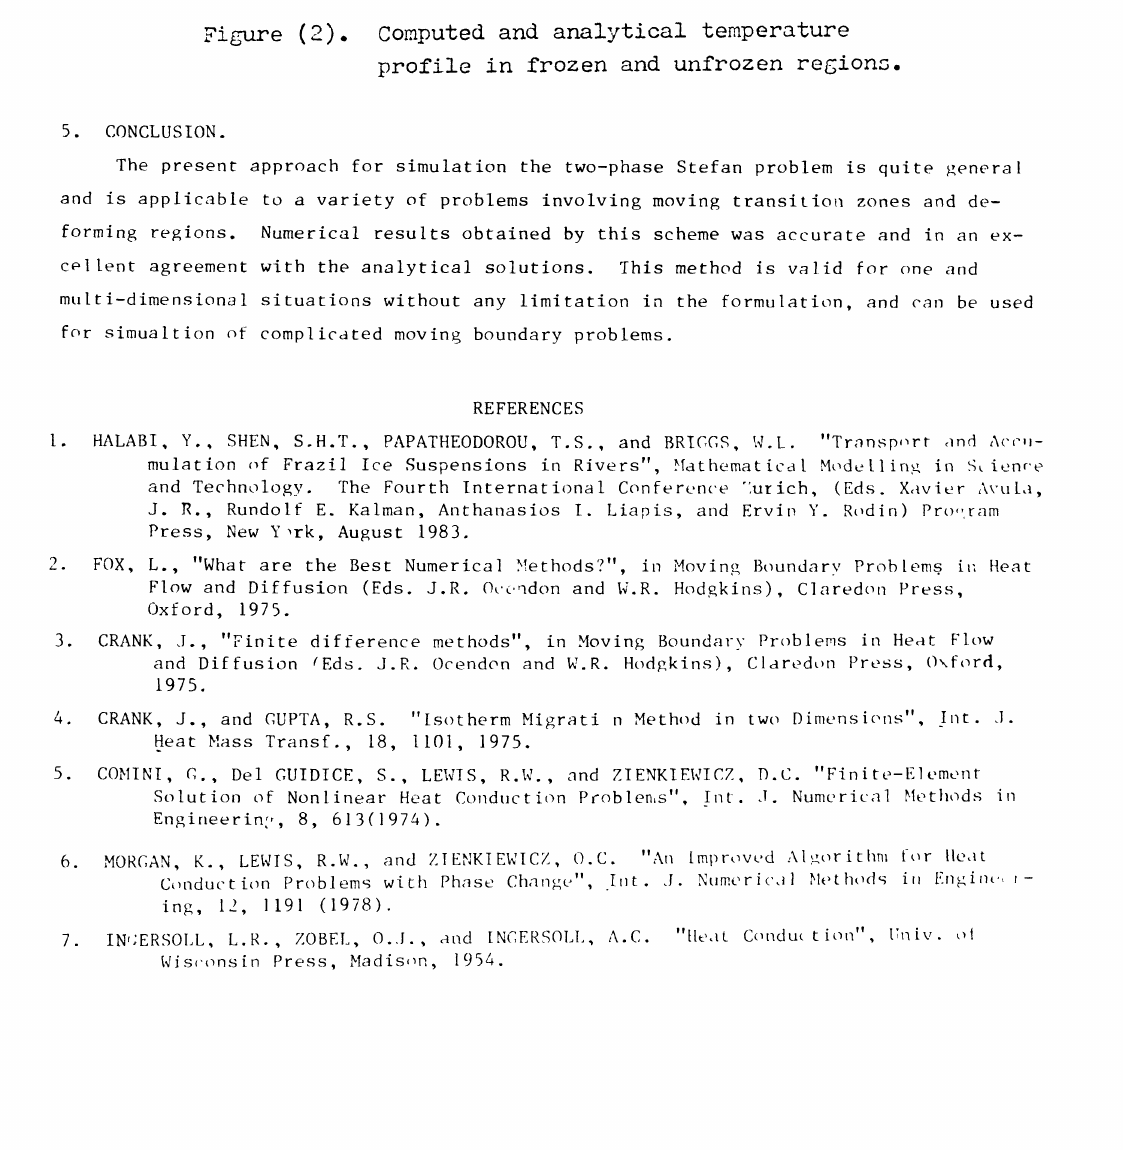
distance X (cm) Figure (2). Computed and analytical temperature profile in frozen and unfrozen